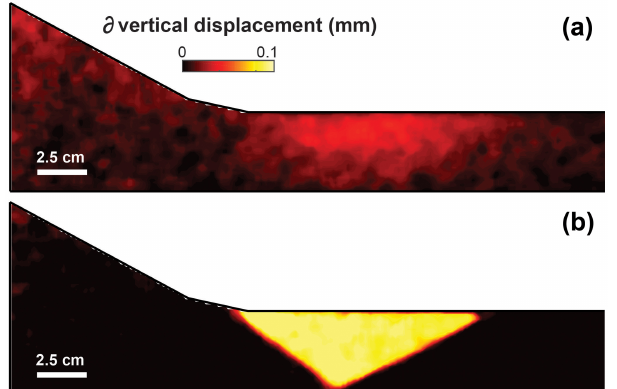
Figure 5. Vertical displacement fields of moving-backwall experi- ment excluding glass bead layer (E375) preceding (a) and following (b) thrust fault development. Preceding thrust development, a broad pattern of uplift forms in the region where the faults ultimately lo- calize. Following thrust development, uplift localizes above discrete thrust faults. As the uplift pattern transitions from gradational to sharply bounded by faults, the overall δW grav increase (Fig. 4).